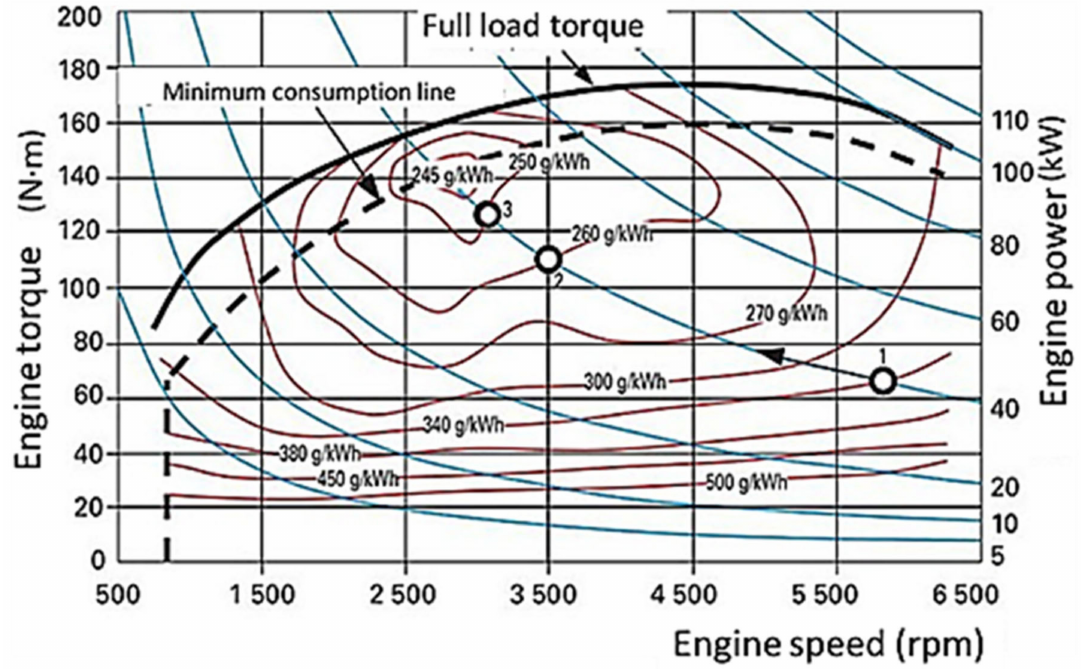
Figure 9. Map of complex specific consumption (red curves) and output power (blue curves) of a diesel engine versus rotation